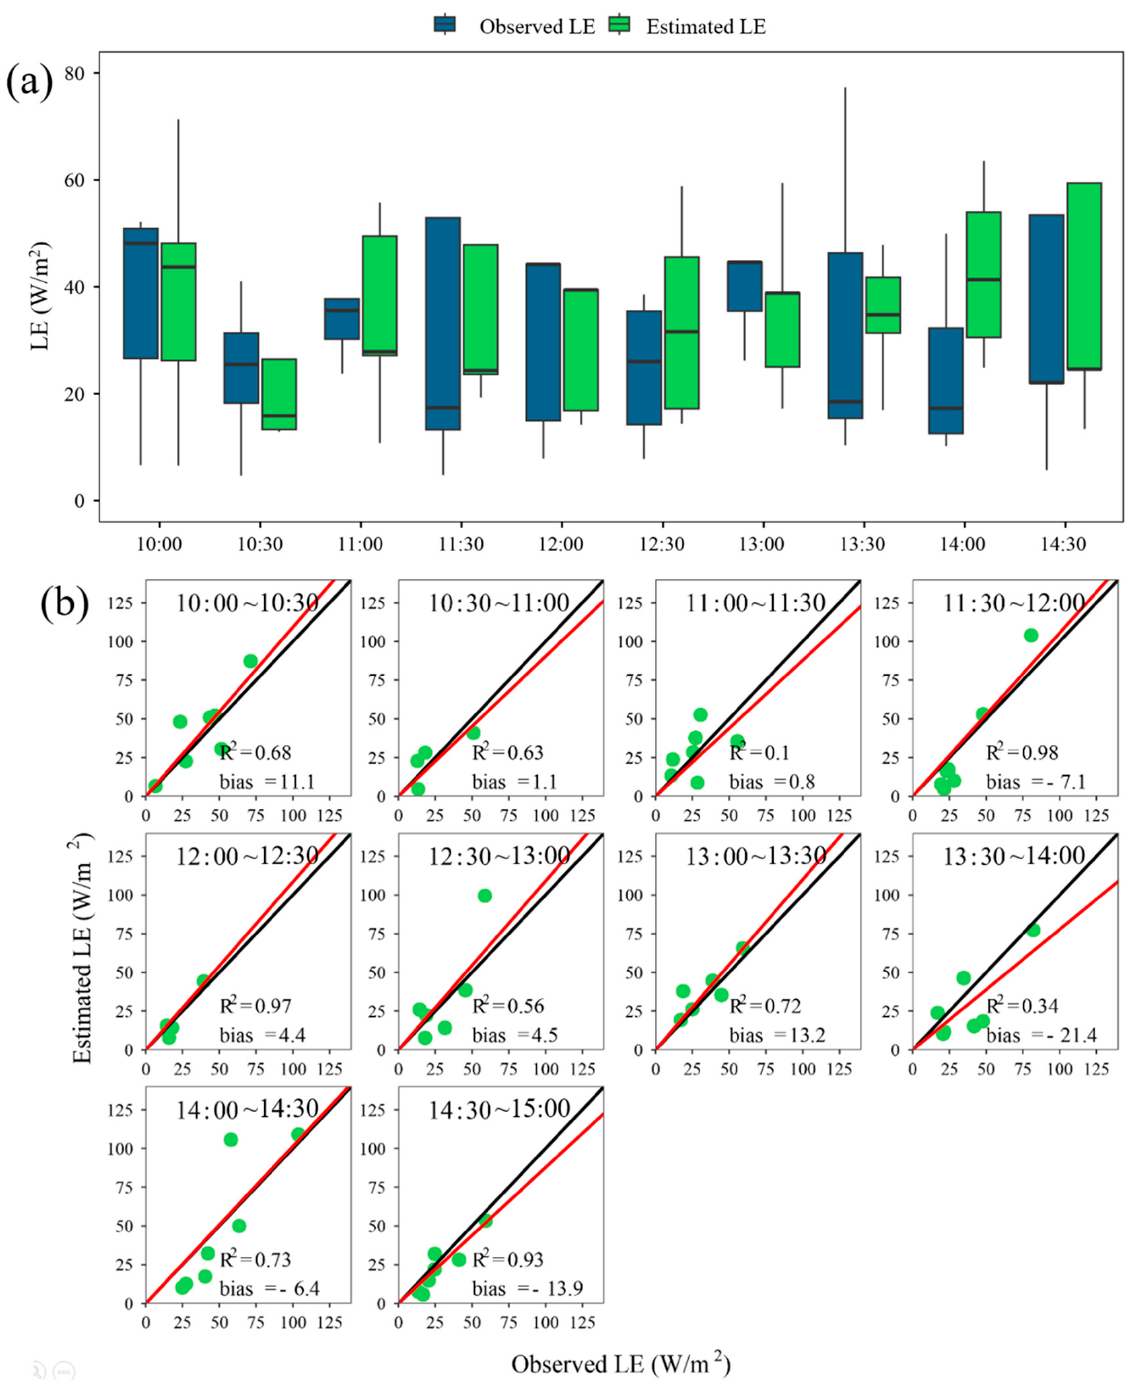
Figure 9. Boxplots showing ( a ) the observed (green fill) and estimated (blue fill) half-hourly LE from 10:00 to 14:30 during the study period; ( b ) the comparison of simulated and observed half-hourly LE. The black and red lines are the 1:1 and linear regressed lines without intercept, respectively. The PT-Urban model performed better from 11:30 to 12:00, 12:00 to 12:30, and 14:30 to 15:00, during which the R 2 values were over 0.9. The linear regression slopes without intercept varied from 0.83–1.18. In general, the PT-Urban model effectively captured the dynamics of the half-hourly LE observed by the flux tower.